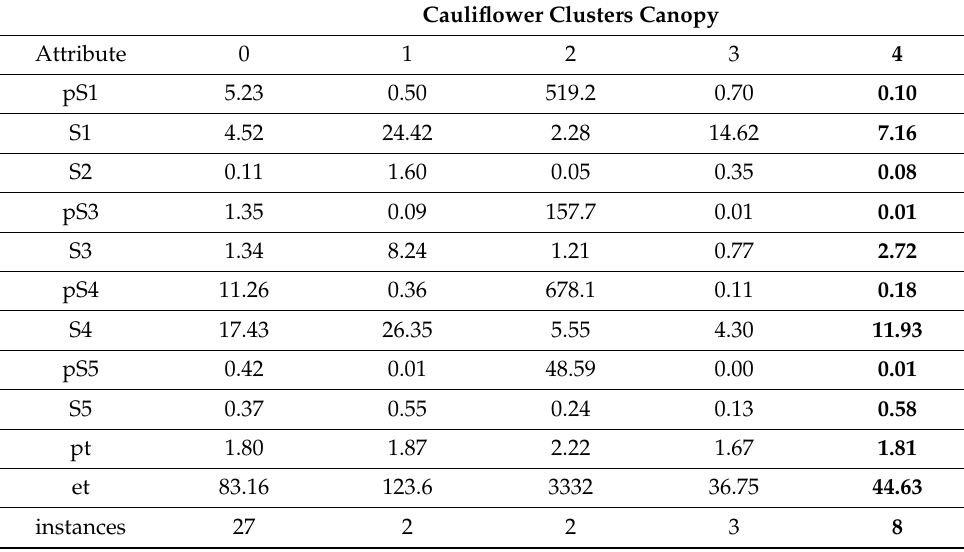
Table 10. Canopy clusterization of cauliflower production.